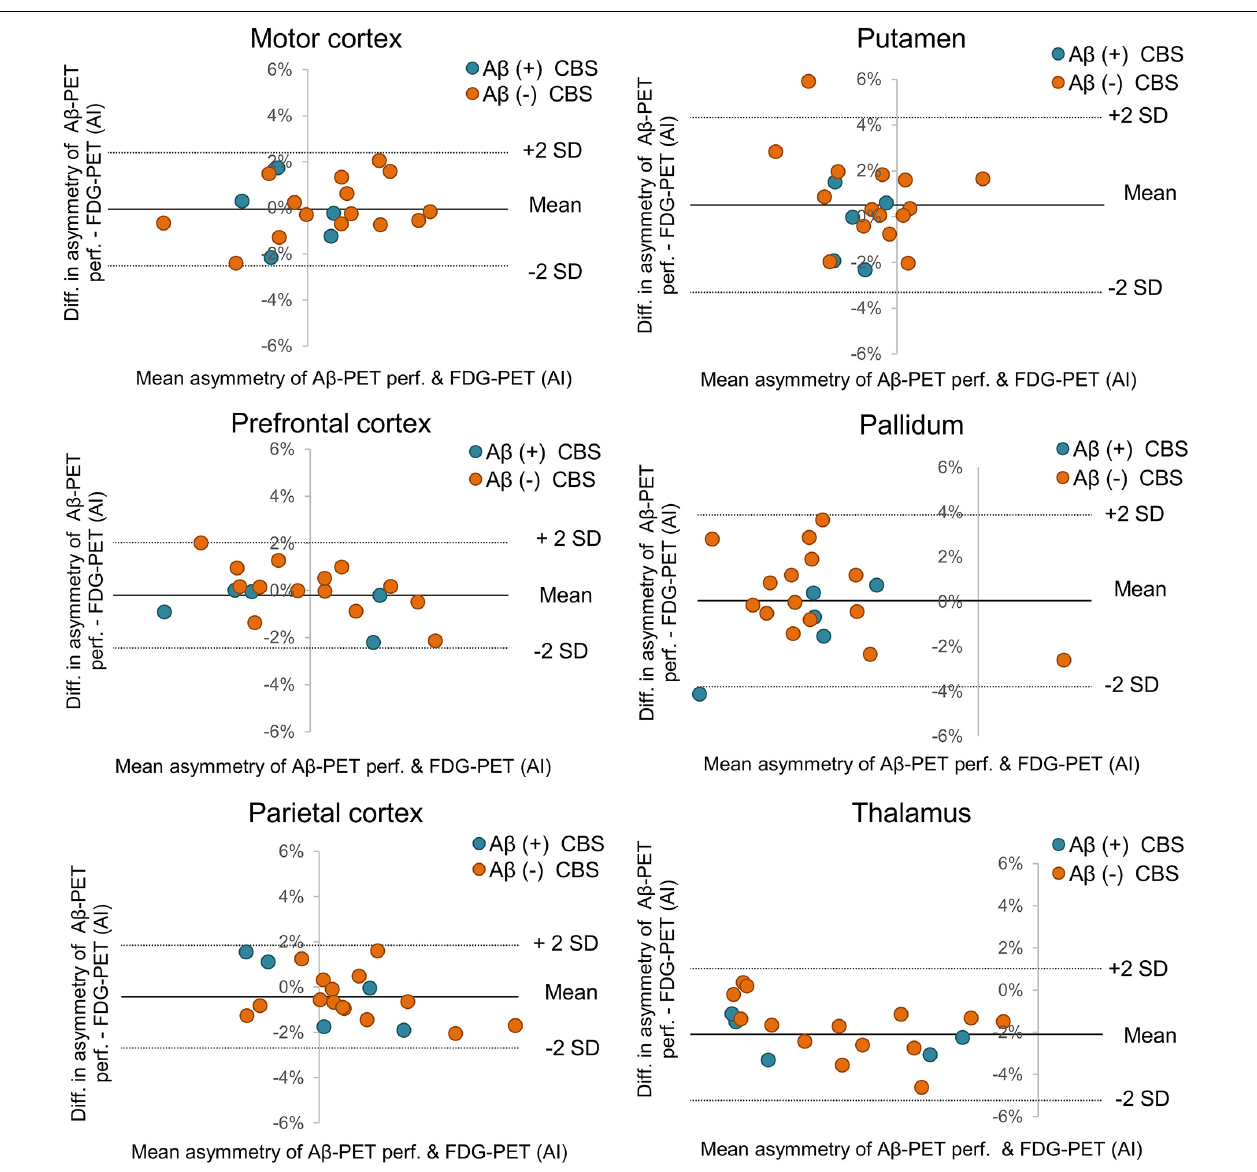
FIGURE 3 | Bland-Altman plot of asymmetry agreement between early phase A β -PET and FDG-PET. Cortical regions with strongest asymmetry in FDG-PET (left column) and subcortical regions (right column) are visualized with respect to individual agreement of asymmetry indices (AI). FDG-PET, 18 F-fluorodesoxyglucose positron-emission-tomography; SD, standard deviation; A β , β -amyloid; R , Pearson’s coefficient of correlation; CBS, corticobasal